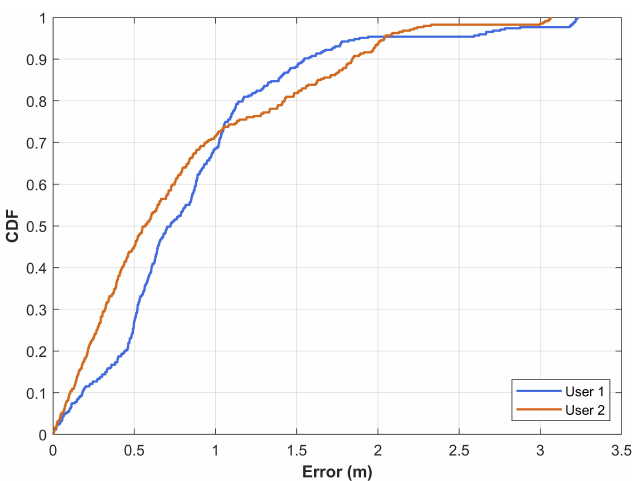
Figure 5. The CDF graph for positioning results involving two users with different heights. The heights of the users are 165 cm and 171 cm for user 1 and user 2,